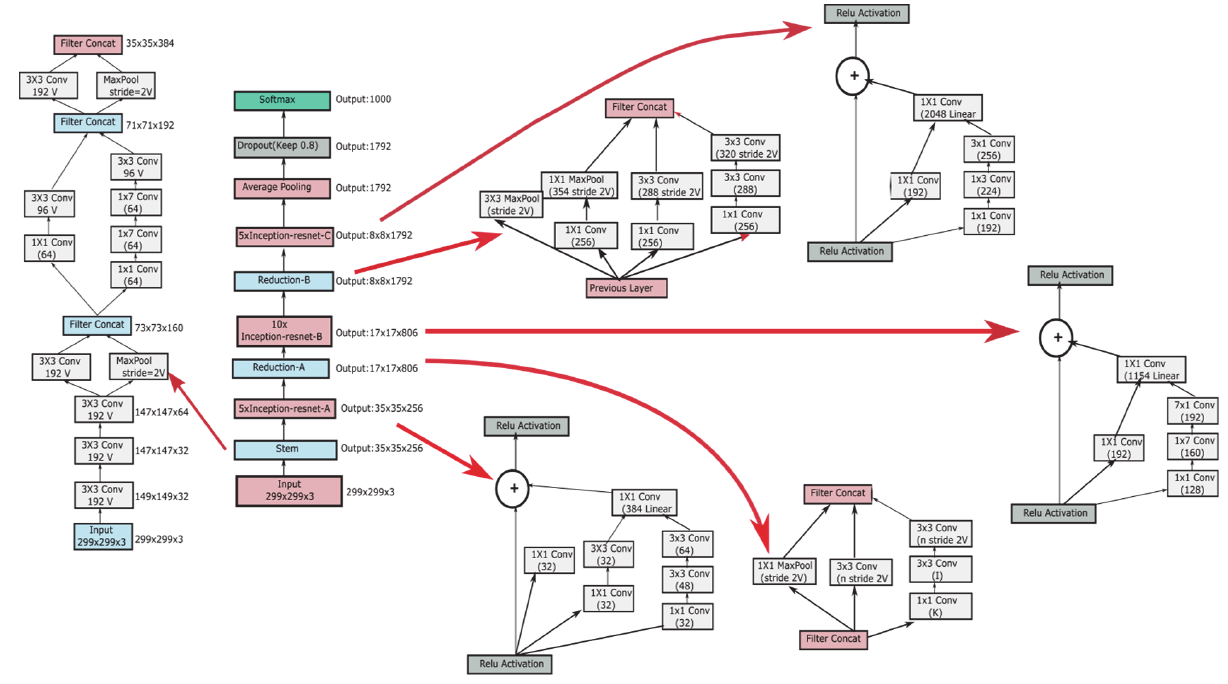
Figure 3. Architecture of CNN